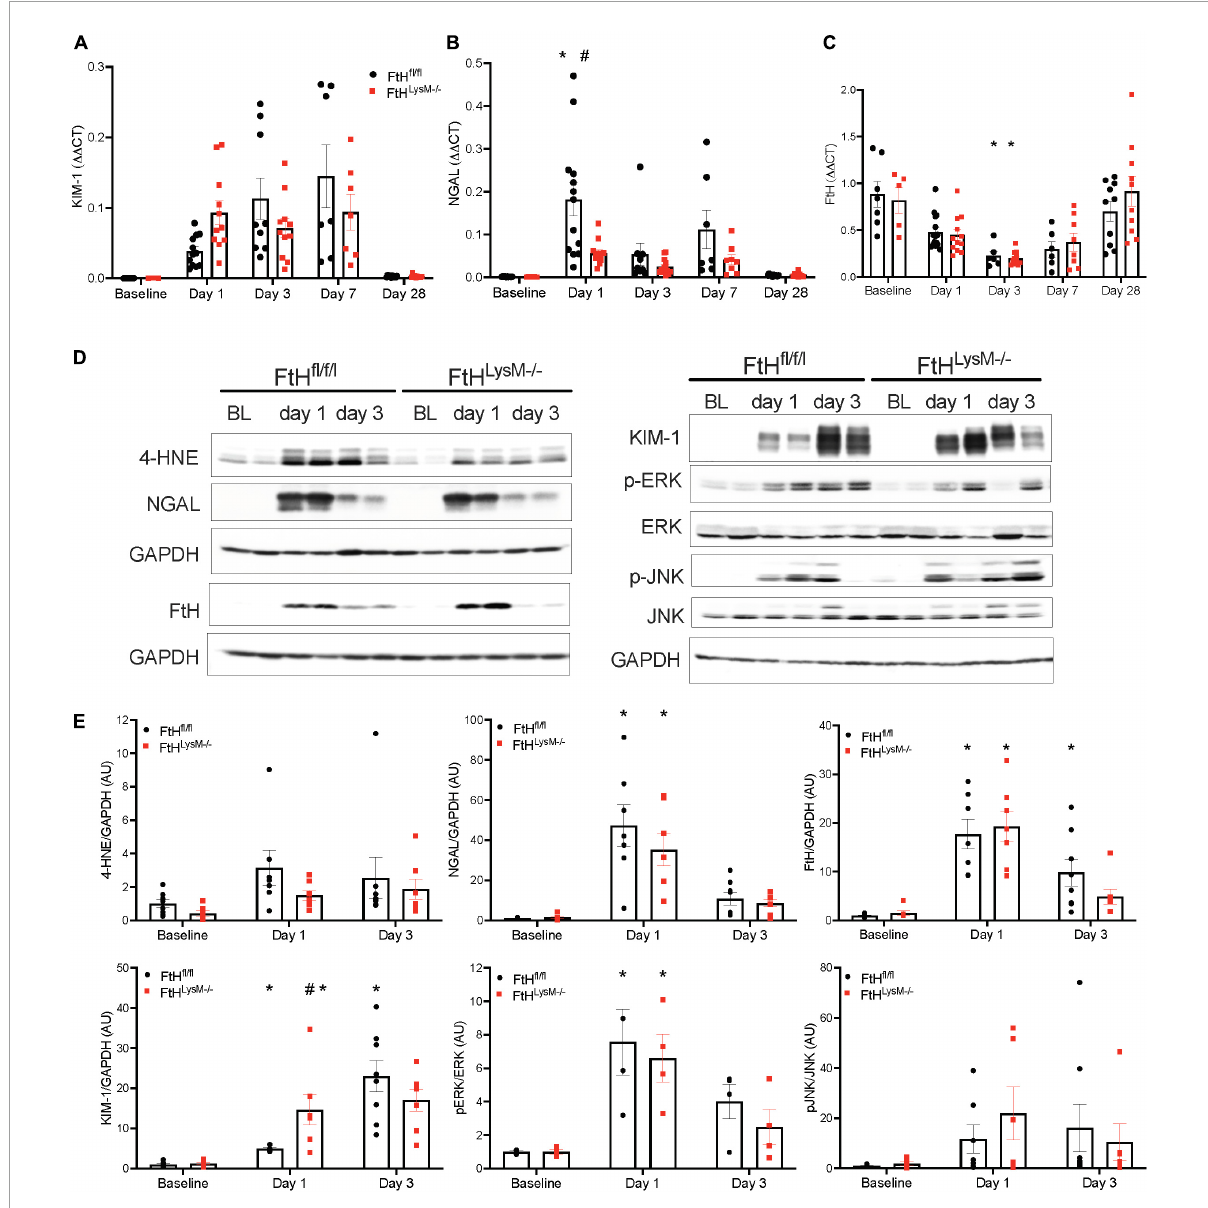
FIGURE3 Elucidation of kidney injury markers and MAPK signaling following rhabdomyolysis. Mice were administered 7.5 ml/kg body weight of 50% glycerol in water and harvested after 1 or 3 days. Kidneys were analyzed for the expression of (A) kidney injury molecule-1 (KIM-1), (B) neutrophil gelatinase associated lipocalin (NGAL), and (C) ferritin heavy chain (FtH) by real-time PCR analysis. Each experiment was performed at least three independent times. Results were normalized to GAPDH and presented as mean ± SEM. * p < 0.05 vs. baseline control; # p < 0.05 vs. FtH fl / fl . (D) Kidneys were analyzed for the expression of 4-hydroxynonenal, NGAL, KIM-1, FtH, p-ERK, total ERK, p-JNK, and total JNK by Western blot analysis. Membranes were stripped and re-probed for GAPDH to demonstrate equal loading. (E) Expression of the indicated proteins in the kidneys was analyzed by densitometry, normalized to GAPDH (or total JNK or total ERK) and expressed as mean ± SEM. * p < 0.05 vs. baseline control; # p < 0.05 vs. FtH fl / fl